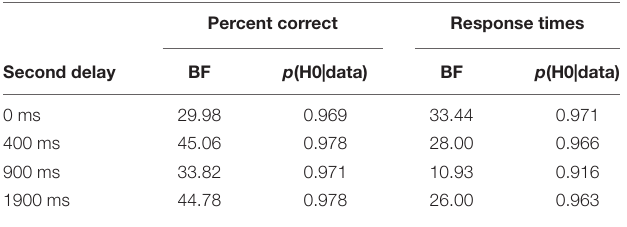
TABLE 5 | Bayes factors (BF) and posterior probabilities for the null hypothesis ( p (H0|data)) according to Masson (2011) for the interaction of set size and cue type (calculations based on n =